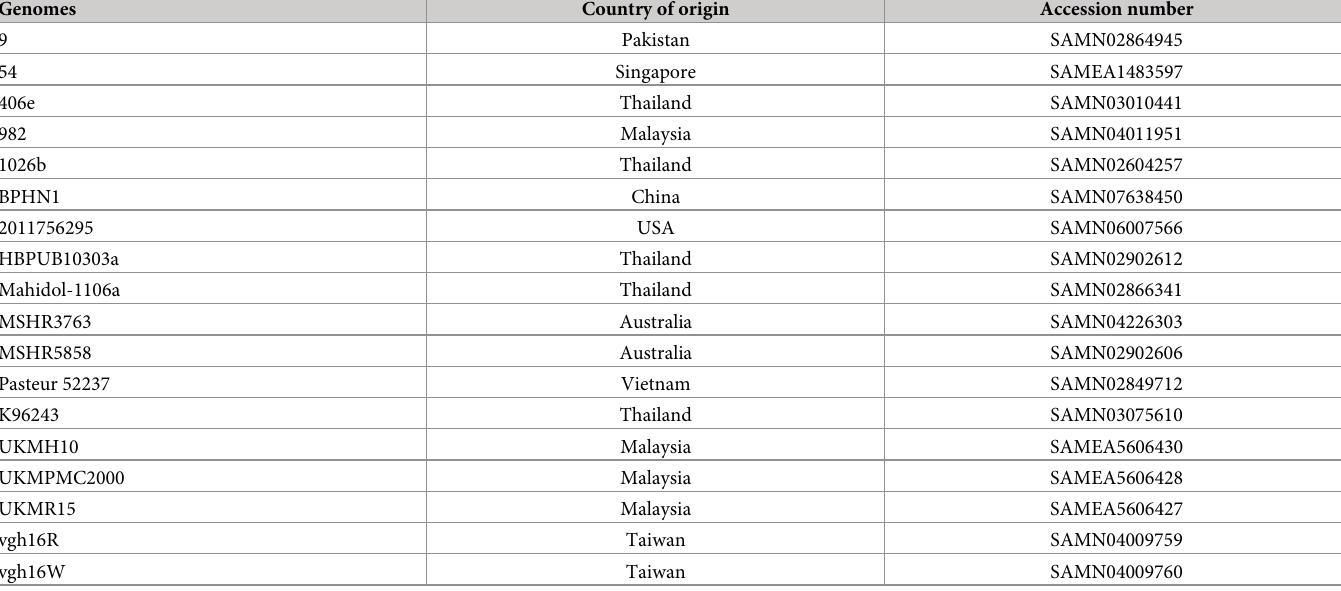
Table 1. List of genomes used for phylogenomic analysis, and country of origin and accession number of the genomes. Genomes Country of